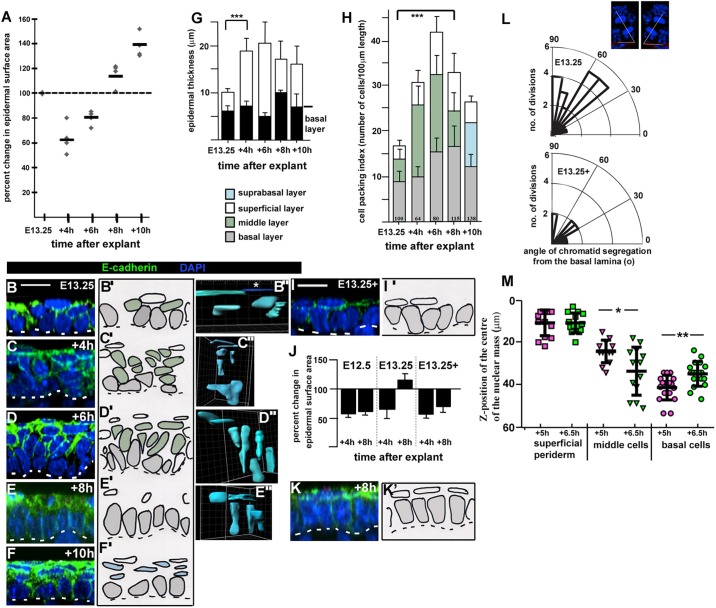
Epidermal spreading is driven by radial intercalation. (A) Scatter plot of epidermal surface area changes in different explants after the indicated number of hours in culture, generated from two different wild-type litters. 100% (dashed line) indicates no change. Horizontal black lines indicate mean values. (B–F) Representative z-stack images of E13.25 explant layer index. Images were taken in the centre of the explants, n=3 explants for each time-point. (B′–F′) Camera Lucida images of B–F. Grey cells are basal layer cells, green cells are middle cells, white cells are superficial periderm cells and blue cells are proliferating suprabasal cells. (B″–E″) 3D reconstructions of live cell shapes over time in Lumox culture. Surfaces were created manually using Imaris (Bitplane) Surpass view. (B″) Asterisk denotes a squamous periderm cell, labelled dark blue for clarity. Three explants were analysed for each time point. Scale bars: 10 µm. The dotted lines represent the basal lamina. (G) Histogram of changes in epidermal thickness over timecourse shown in A. Results are mean±s.d. ***P<0.0001 (two-tailed t-test). (H) Histogram of changes in cell packing in explants over the timecourse shown in (A). Bars are colour coded as images in B′–F′. Results are mean±s.d., n>3 explants from each time point. Average percentage change in surface area for each time point (A) is indicated above the x-axis. ***P<0.0001 (two-tailed t-test against basal layer packing). (I,I′,K,K′) As B–F′ with n=3 explants. (J) Histogram of explant spreading at t=4 h and t=8 h, comparison of n=3 explants for each stage taken at E12.5, E13.25 and E13.25+3–4 h. Results are mean±s.d. (L) Polar plots of angle of chromatid segregation from the basal lamina. Telophase divisions: the mean angle of their oriented cell division was measured relative to the basal lamina (see insets, top right). Insets are representative examples of the methodology used. (M) Scatter plots showing relative z-position of the nuclear mass of the same live cells at E13.25+5 h (magenta) and E13.25+6.5 h (green) with respect to the top of the superimposed z-stack images. Black lines indicate mean±s.d. A total of 44 GFP-expressing cells were analysed, n=14 superficial periderm cells, n=12 middle cells and n=18 basal cells. *P<0.05; **P<0.005 (two-tailed t-test).